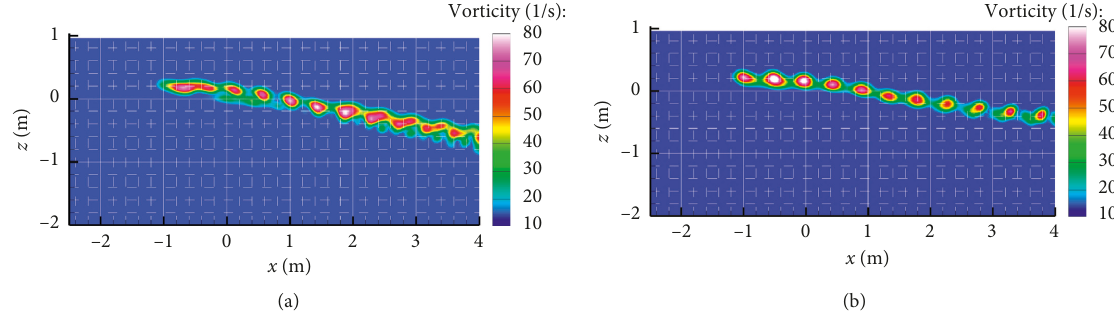
Figure 15: Predicted wake vorticity contour of ECR with 6 ∘ pre-index angle over the longitudinal planes. (a) Plane at y � 0.6 R on the advancing side; (b) plane at y � − 0.7 R on the retreating side.